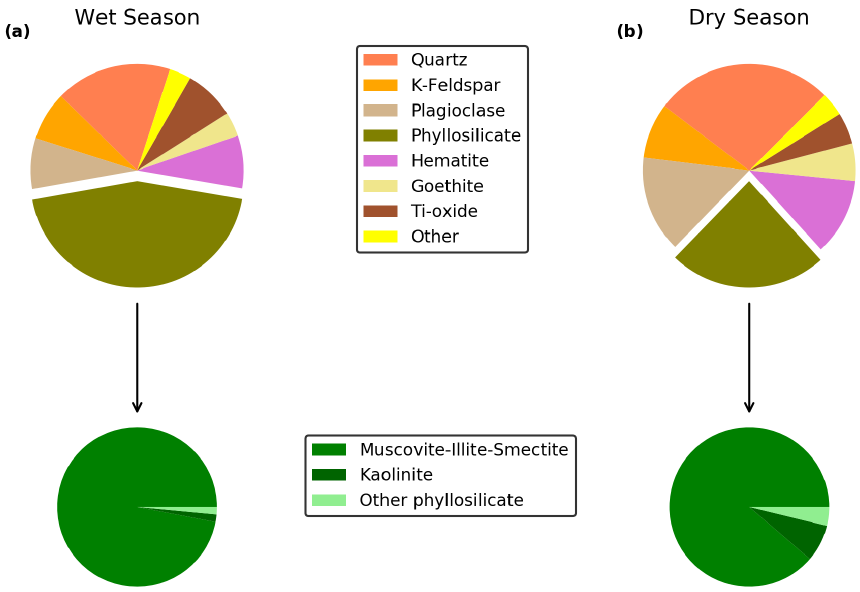
Figure 4. Changes in dust mineralogy between (a) the wet and (b) the dry seasons. The lower plots highlight the mineralogy of the phyl-